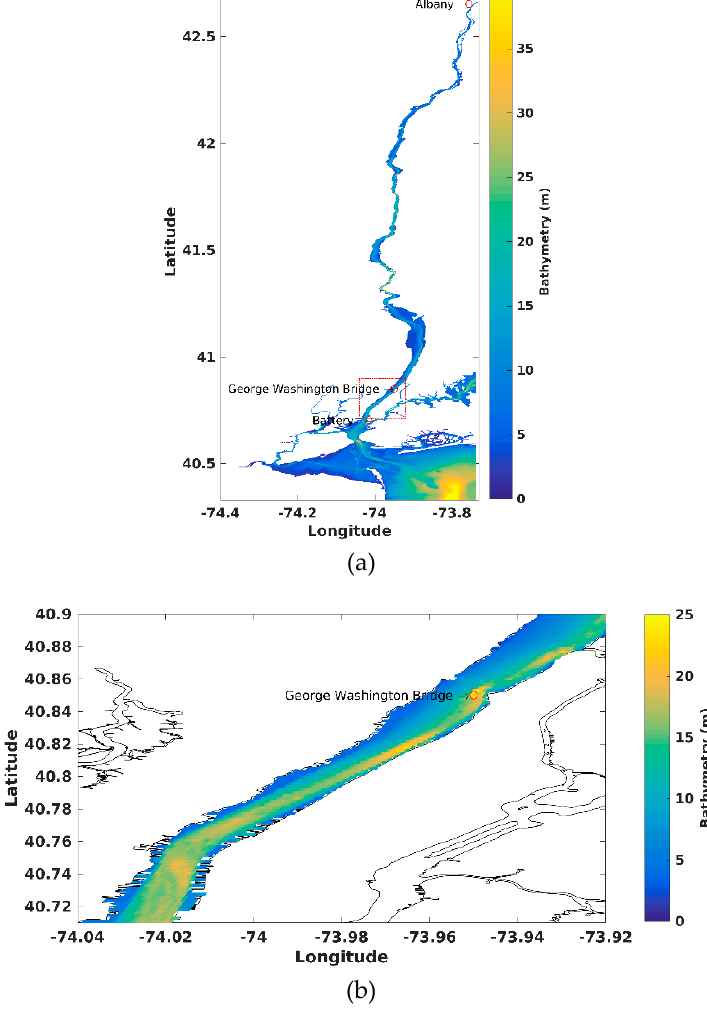
Figure 8. ( a ) Hudson River estuary grid (rectangular box on the figure shows area of interest), ( b ) Close up on the area of interest at the lower part of Hudson River